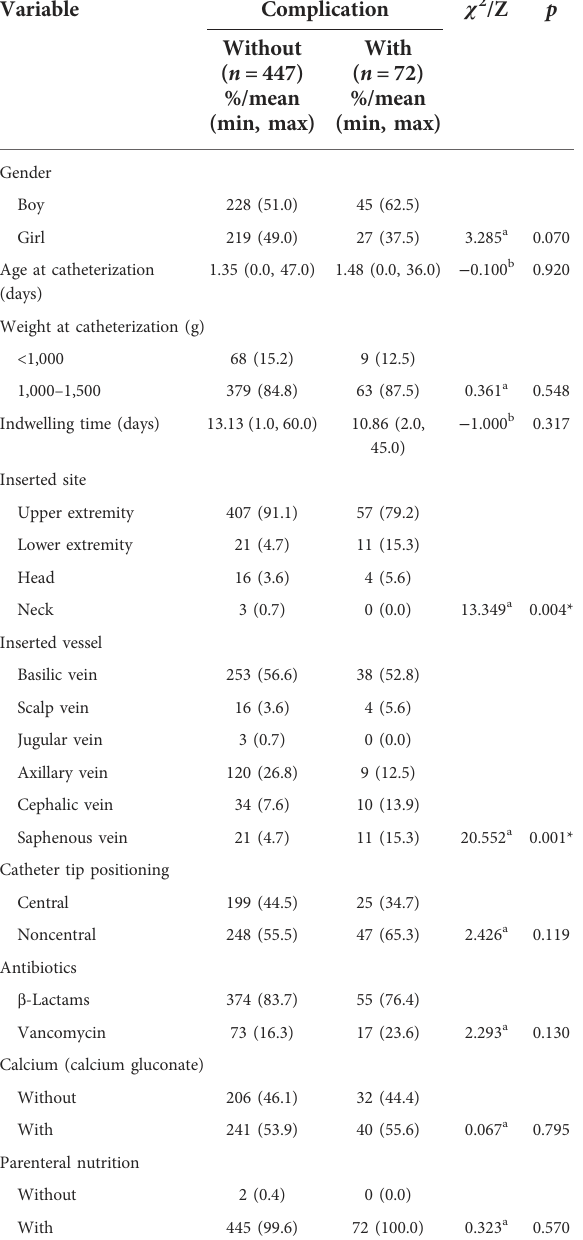
TABLE 3 Univariate analysis of PICC-associated complications in ELBW/VLBW infants.